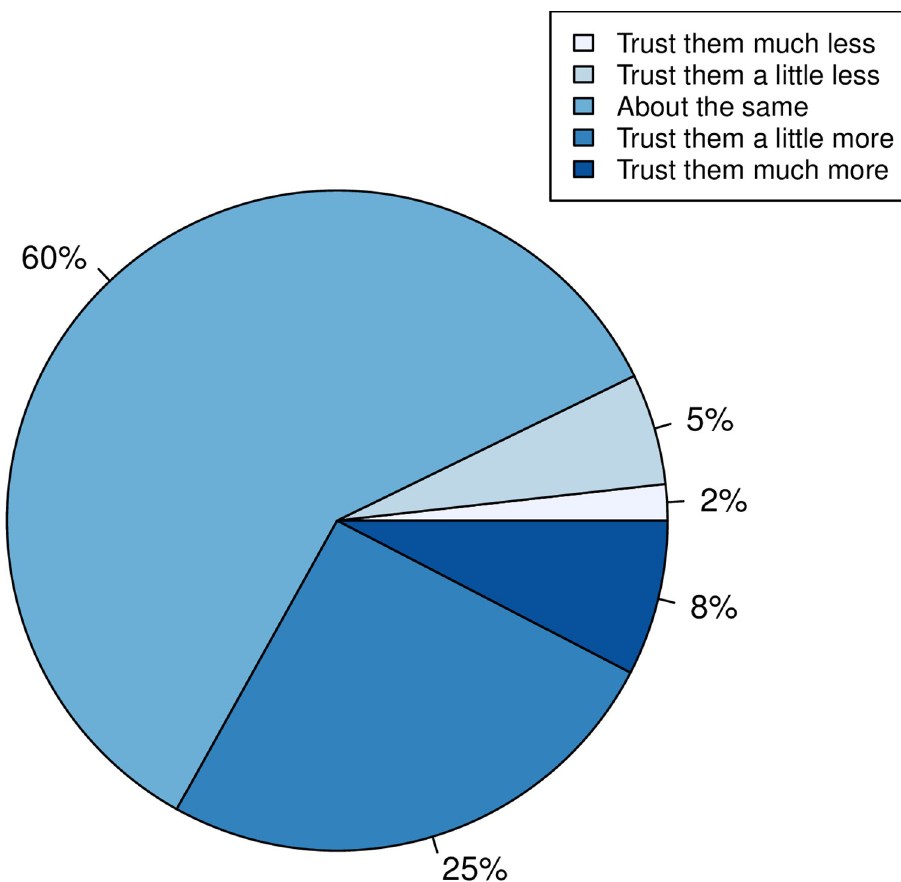
Fig 1. Proportion of individuals in each class of self-reported change in trust in “scientists” during the COVID-19 pandemic (N =